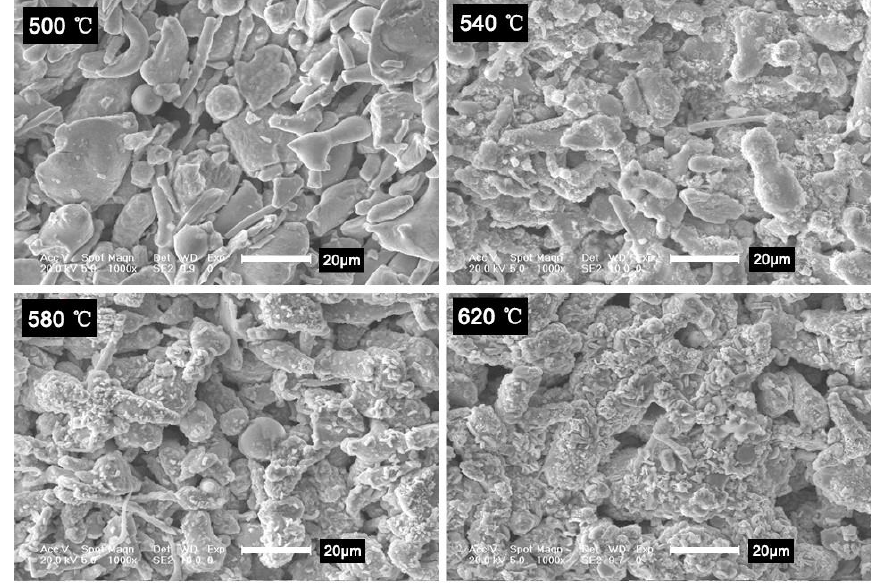
Figure 8. SEM images of parts sintered at different temperatures (magnified 1000 times).